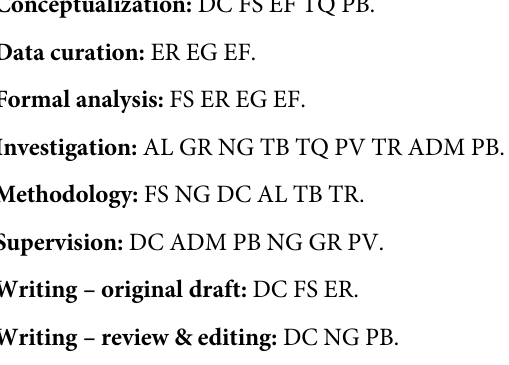
S1 Table. HAART regimen—Overall. S2 Table. HAART regimen by CP category: category = 1 . first line therapy. S3 Table. HAART regimen by CP category: category = 2. Toxicity/other. S4 Table. HAART regimen by CP category: category = 3.